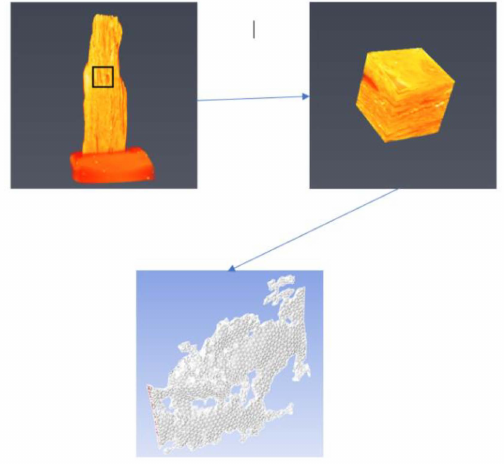
Figure 2. CT scan